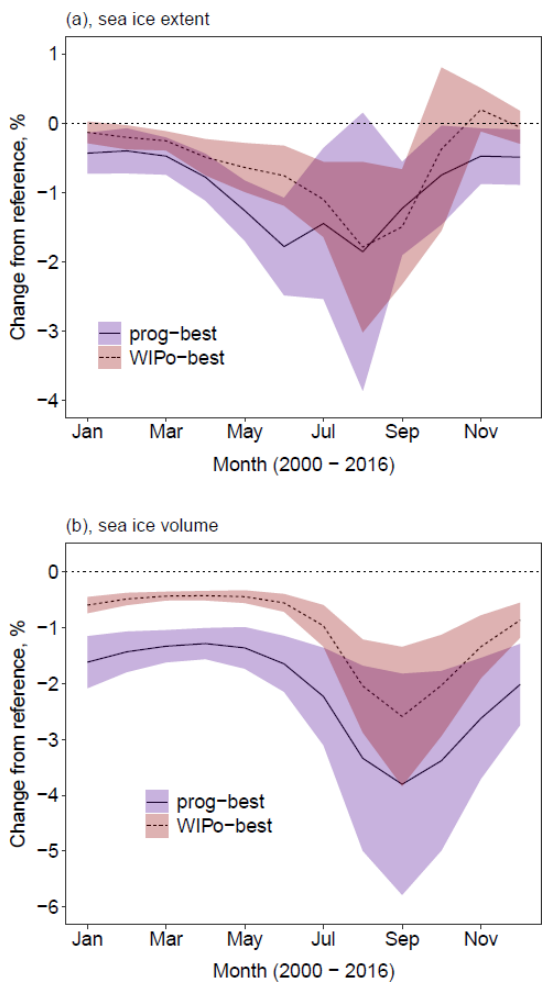
Figure 7. Difference in sea ice extent (a) and volume (b) of prog- best (solid, blue shading) and WIPo-best (dashed, red shading) rel- ative to ref averaged over 2000–2016. The shading shows, in each case, plus or minus 2 times the standard deviation around the